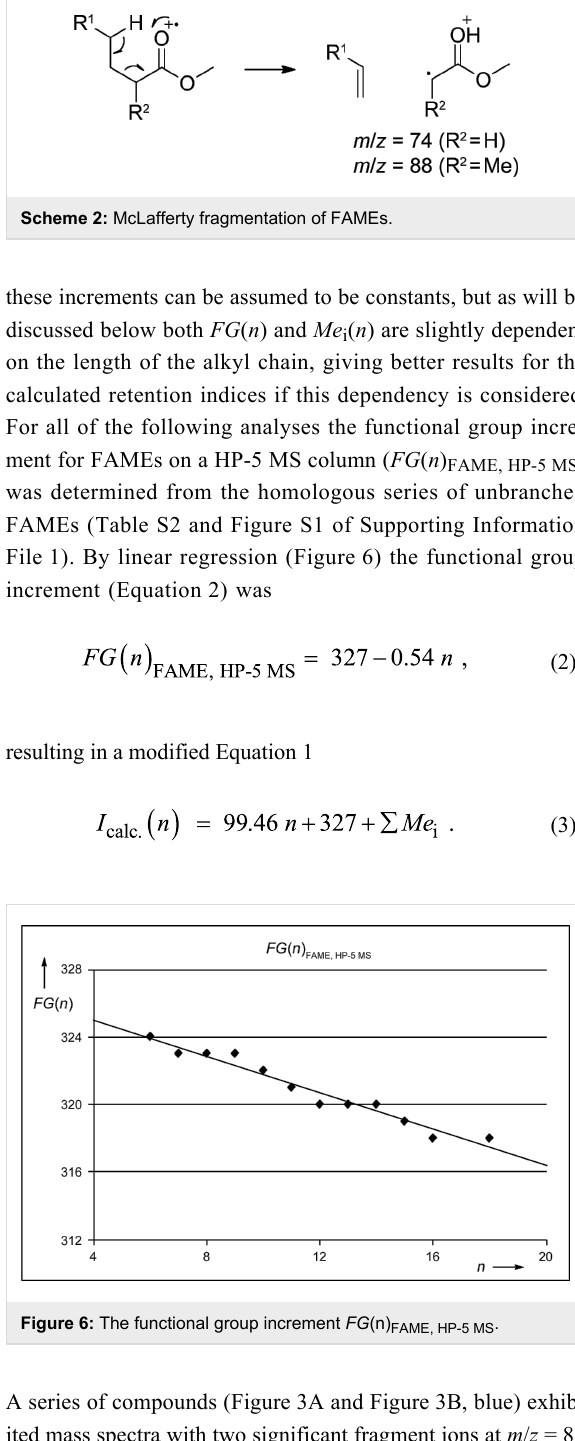
A series of compounds (Figure 3A and Figure 3B, blue) exhib- ited mass spectra with two significant fragment ions at m / z = 88 as the base peak and at m / z = 101, indicating a methyl branching in a α -position (Scheme 2, cf. Figure 5B for mass spectrum of methyl 2-methyldecanoate). For the determination of the increment Me α the reference compound methyl 2-methyldecanoate ( 10 ) was synthesised by α -alkylation of 82 (Scheme 3). The mass spectrum and retention index ( I =